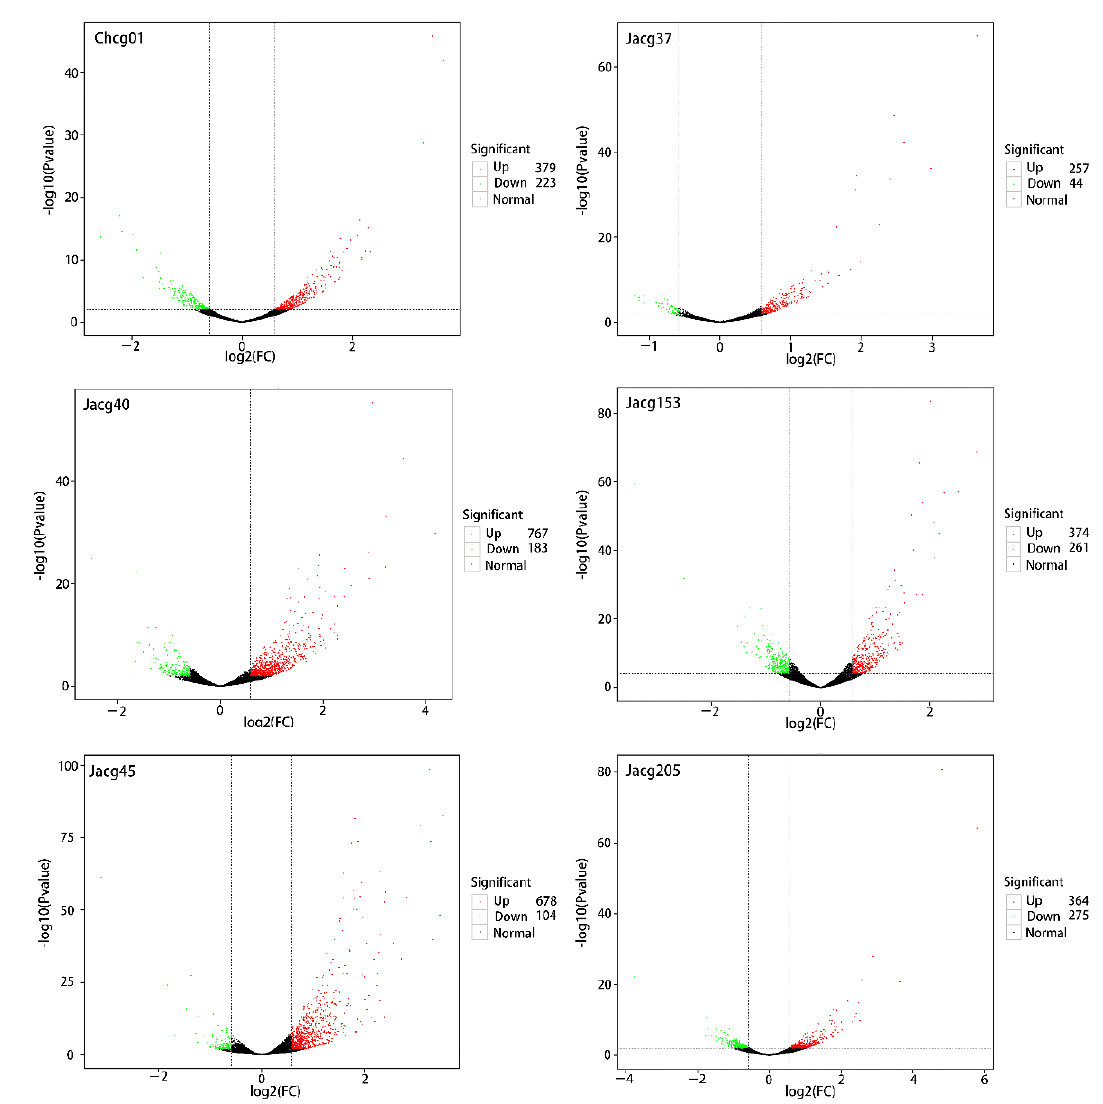
Figure 4. Volcano map of the candidate genes induced by the drought treatments. Volcano map shows the differentially expressed genes (DEGs) of six Cenococcum geophilum after 10% PEG-6000 treatment compared to 0% PEG-6000. Red spot indicates significant up-regulated genes after drought treatment; green spot indicates significantly down-regulated genes; and black spot indicates no-change genes. |log2Foldchange| ≥ 1.5 are used as the screening criteria of DEGs.